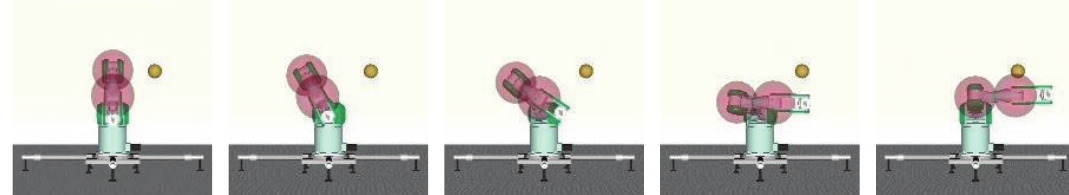
Figure 14: Scenes in Case 2 of obstacle avoidance simulation.